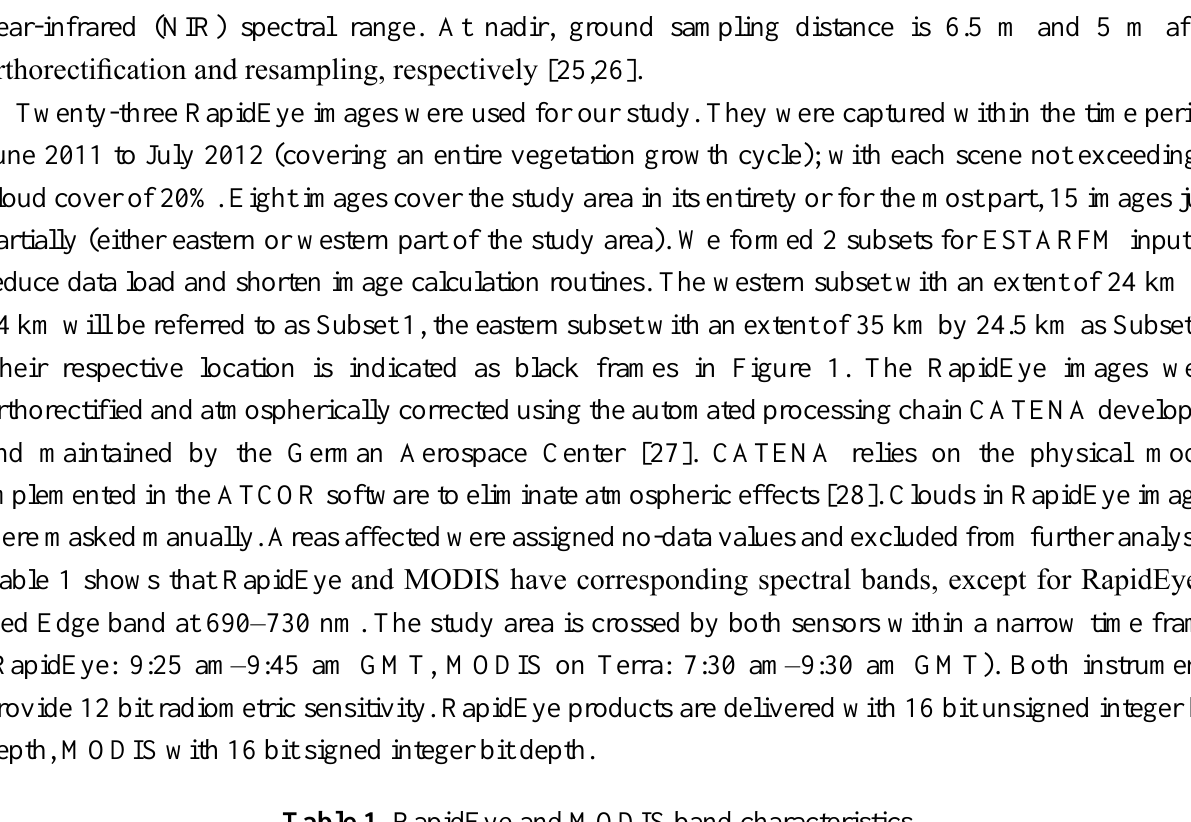
Table 1. RapidEye and MODIS band